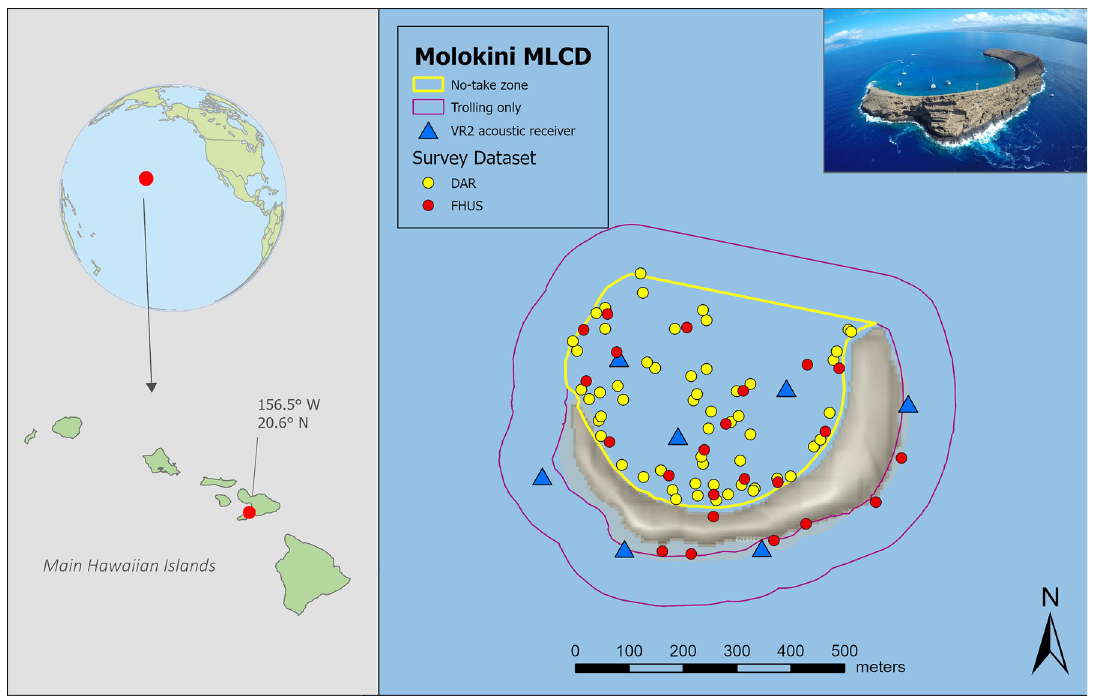
Fig 1. Map of the study site, Molokini Shoal Marine Life Conservation District, located in Maui, Hawaii, USA. Blue triangles show locations of acoustic tracking receivers, yellow and red dots show locations of fish surveys, yellow line shows the boundary of the no- fishing zone inside the crater, and red line shows the boundary of the trolling-only zone around the outside of the crater. Hillshade basemap derived from USGS Digital Elevation Model (DEM) [43]. The partially submerged volcanic crater that forms a wall around the interior is shown in the aerial photo (’Molokini Crater’ by Bossfrog from Wikimedia Commons under the Creative Commons Attribution-Share Alike 4.0 International